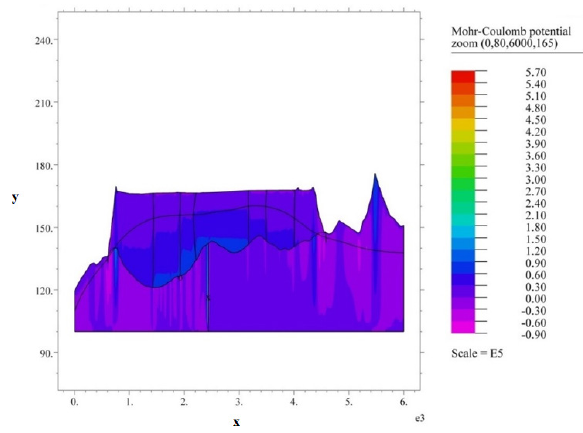
Figure 9: Results for the 2D model – Coulomb–Mohr